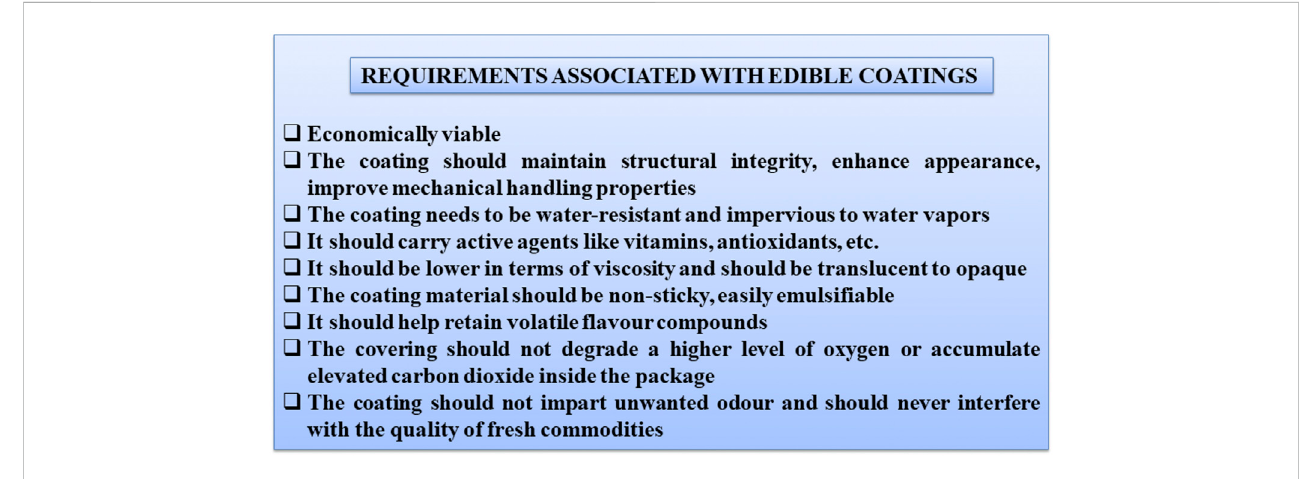
FIGURE 5 Requirements for edible coatings in food